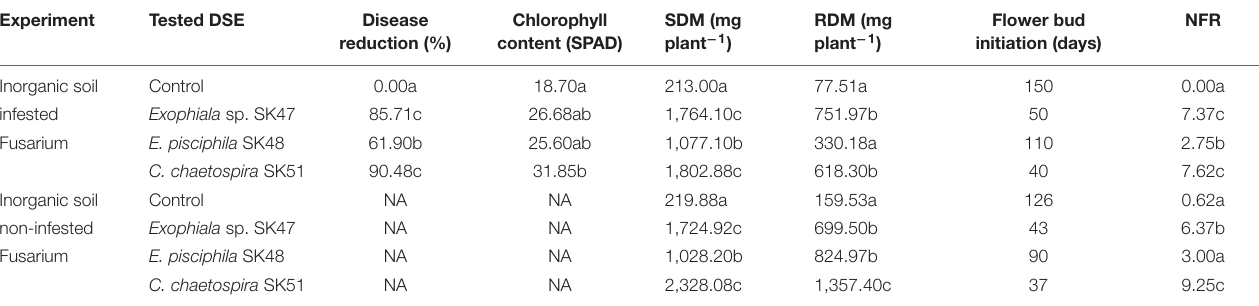
FIGURE 4 | Strawberry crowns cut longitudinally; exposing vascular tissue discoloration (shown by arrow). (A) Infested Fof and non-treated DSE (positive control). (B) Non-infested Fof and non-treated DSE (negative control). (C) Infested Fof, treated DSE. TABLE 3 | Effectiveness of DSE fungal isolates on disease reduction, chlorophyll content, growth parameters: shoot dry mass (SDM), root dry mass (RDM), beginning of flowering and fruiting, and number of fruit (NFR) at the end of experiments 1 . Experiment